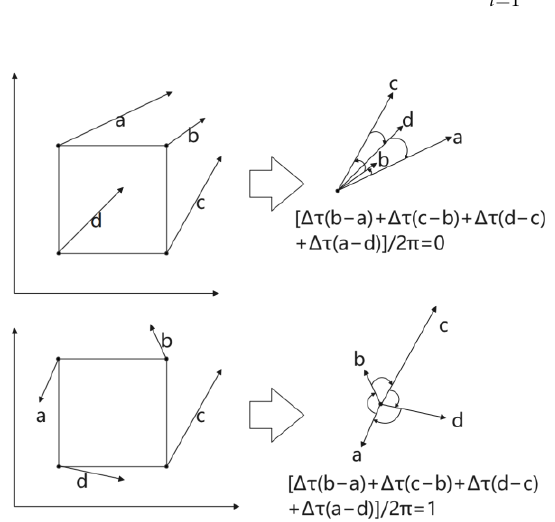
Figure 3. The sum index of angle difference schematic.